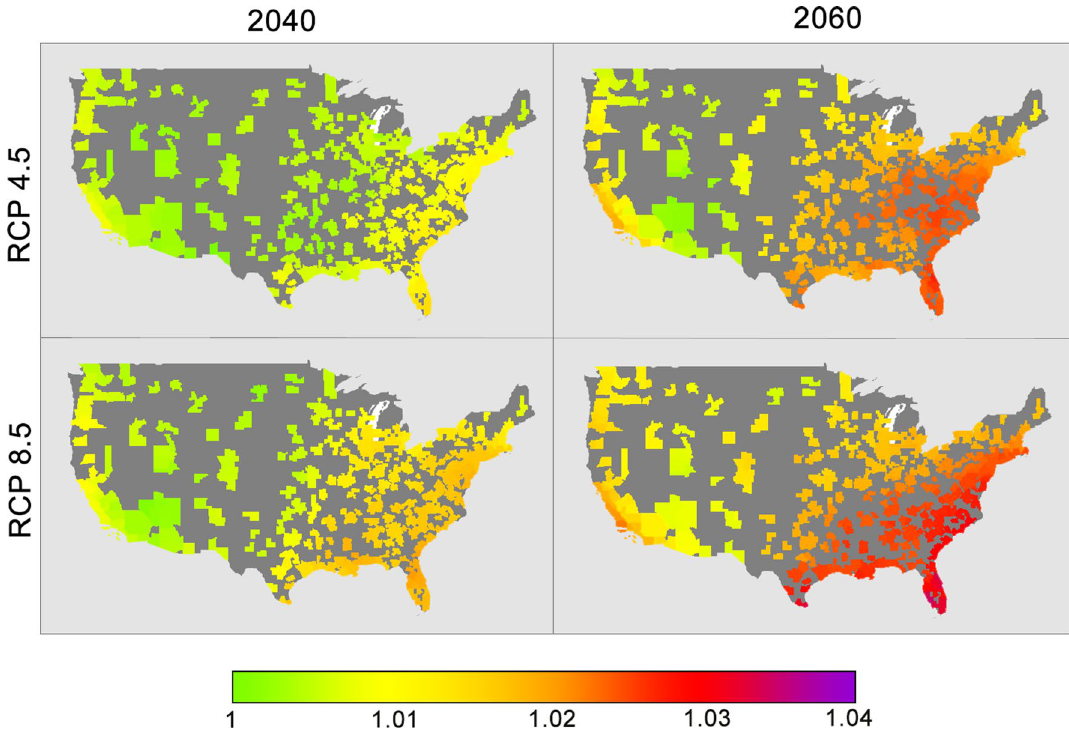
Figure 2. Odds ratios for surgical site infection across all 393 MSAs compared to 2010, with each figure representing a unique combination of Representative Concentration Pathway (RCP) scenarios and year of prediction. Odds ratios were calculated using CMIP5 predictions of precipitation, specific humidity, and temperature multiplied by the multivariable multinomial logistic model coefficients for SSI